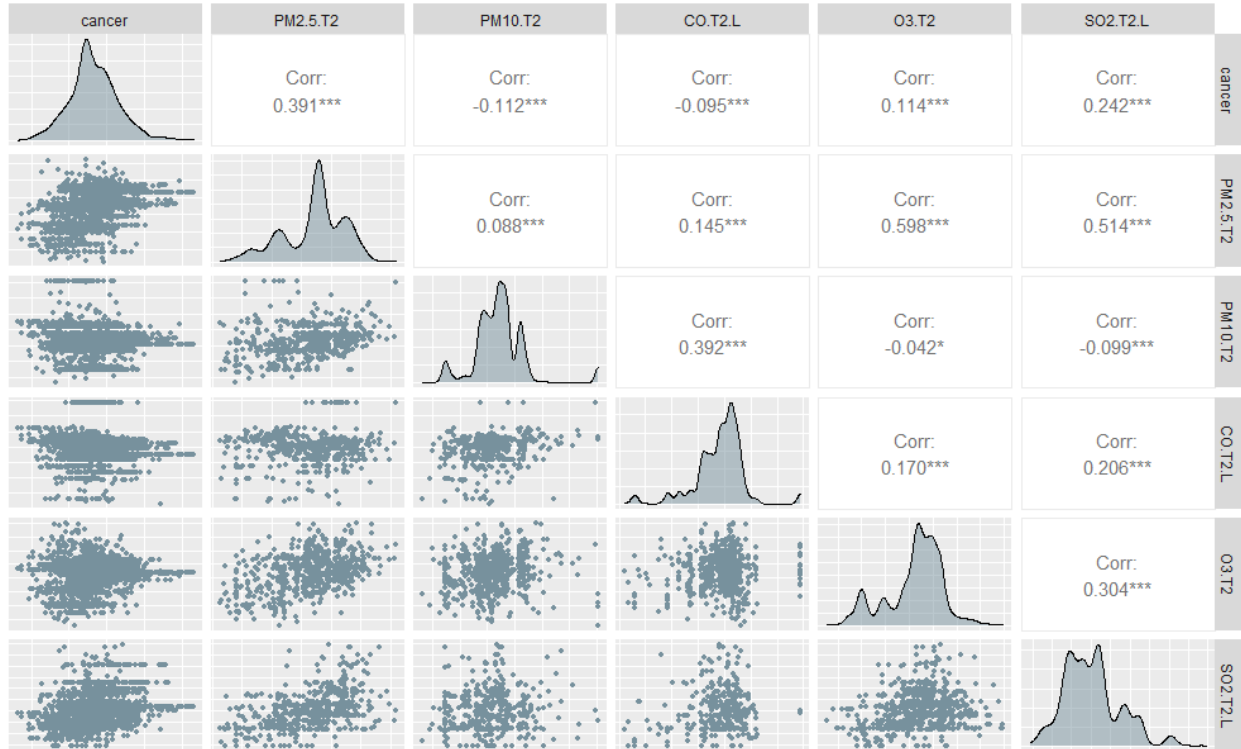
Figure 5 . Matrix Plot of Lung Cancer with Micro Variables in Time 2: Particulate Matter 2.5, Particulate Matter 10, Carbon Monoxide, Tropospheric Ozone, Sulfur Dioxide. Significance codes: 0 ‘***’ 0.001 ‘**’ 0.01 ‘*’ 0.05 ‘.’ 0.1 ‘ ’ 1.